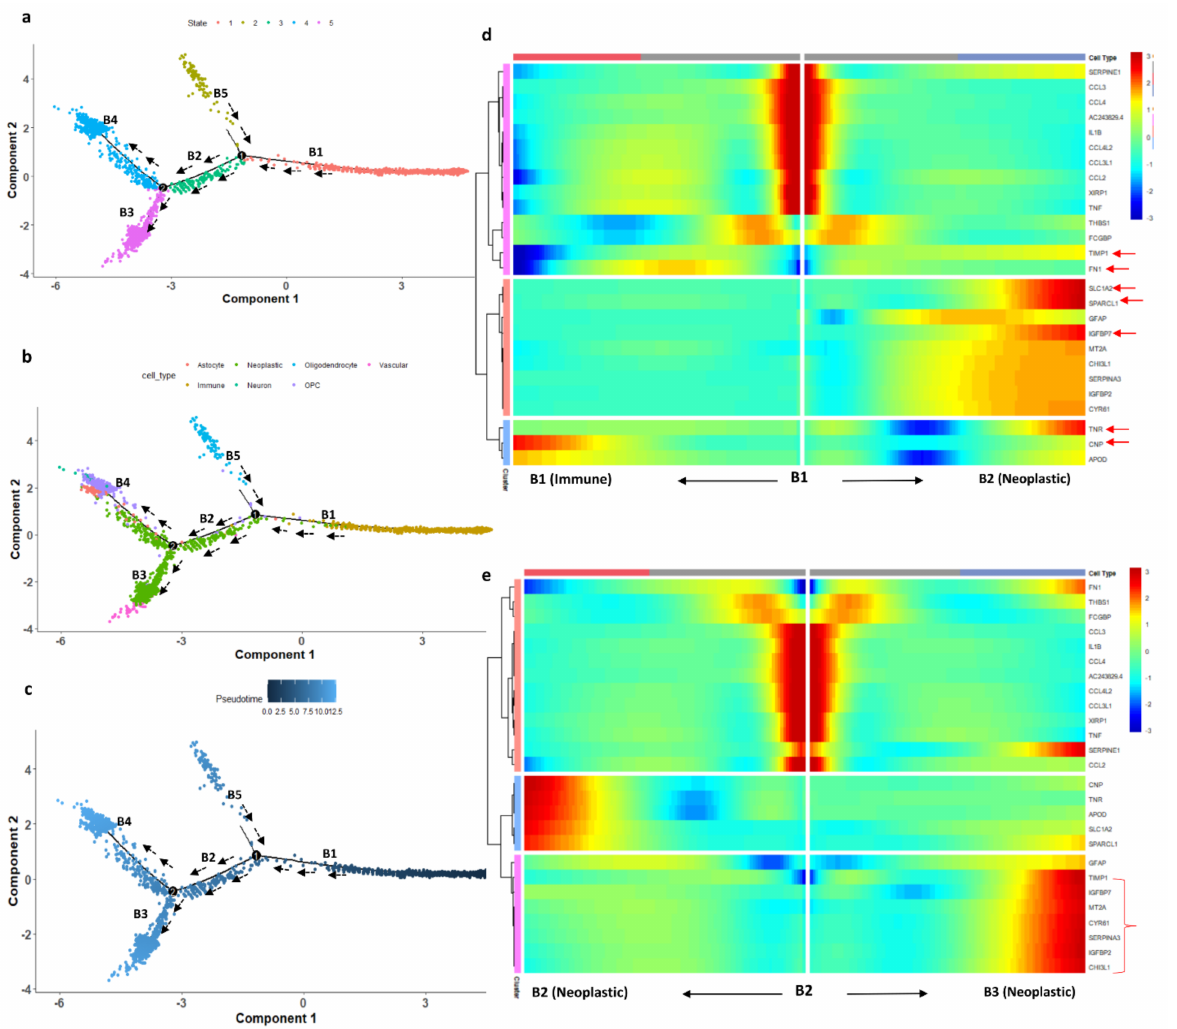
Figure 7. ( a ) DDR three-dimensional reduction of the cells computed using Monocle 2 contains five main branches; the cells took the path based on the pseudotime represented with the black arrow. ( b ) Trajectory states based on cell type. ( c ) Trajectory based on pseudotime. Dark blue represents the initial state (less differentiated) of the immune cells and light blue (more differentiated) represents the differentiated cell state (neoplastic cells). ( d ) Heatmap depicting the transition state of microglial marker genes in a branch-dependent manner for root points 1 and 2. Each row represents the dynamic expression of a gene. ( e ) Branch point 2 set as the root; the left arrow shows the root to the trajectory path 2; the right arrow shows the root to trajectory path